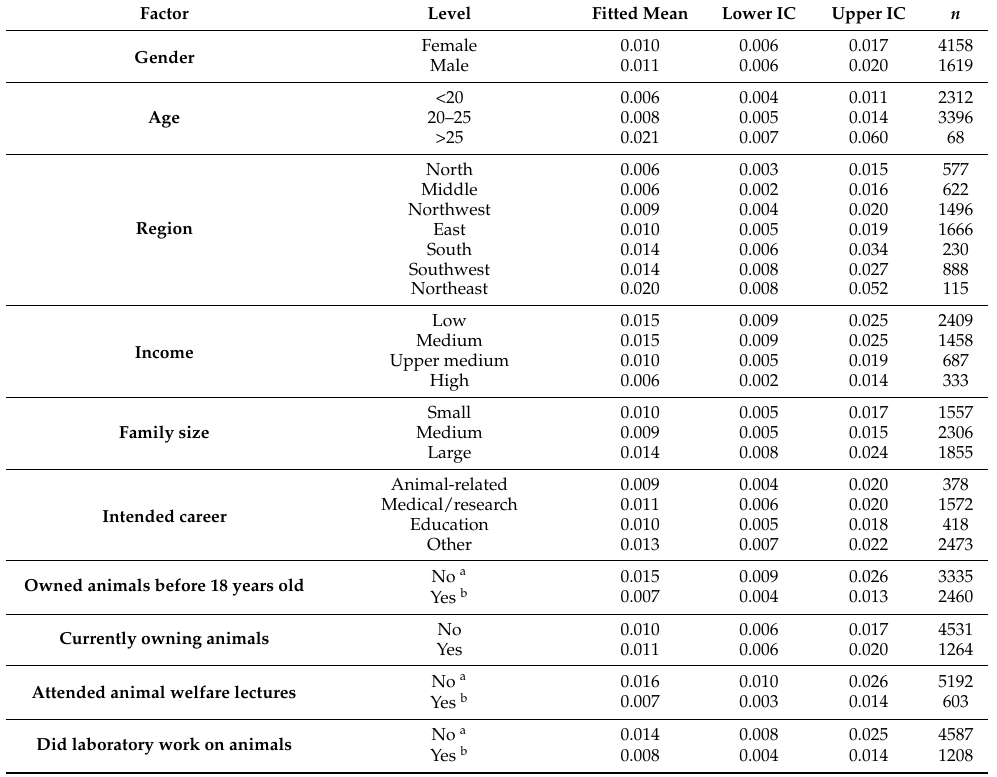
Table 5. Means of uncertainty rate and 95% confidence intervals (CIs) according to the students’ characteristics. Within each factor, categories that share the same letter do not differ significantly, categories that have no letter in common differ significantly or tend to differ (Wald chi-squared tests with Bonferroni correction). n = number of